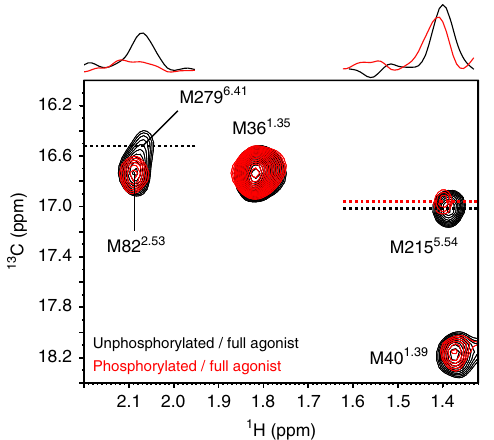
Fig. 3 Conformation of the TM region of phosphorylated β 2 AR. Overlay of the 1 H- 13 C HMQC spectra of [ 2 H-9AA, αβγ - 2 H, methyl- 13 C-Met] β 2 AR in rHDLs in the unphosphorylated state (black) and phosphorylated state (red). Cross-sections of the resonances from M215 5.54 and M279 6.41 are shown above the